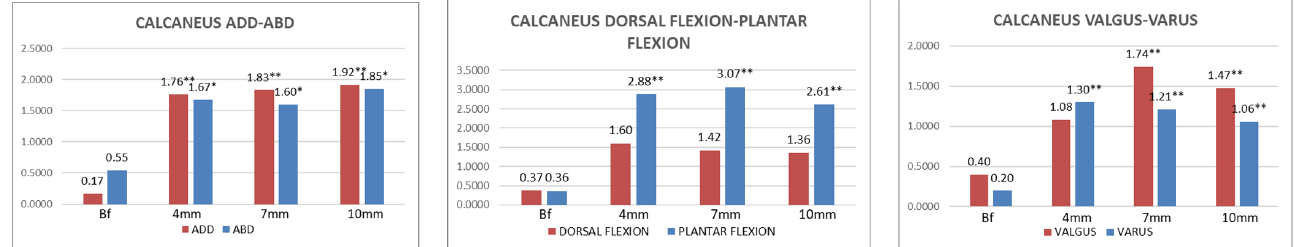
Figure 5. Graphical summary of the degrees of movement in adduction, abduction, dorsal flexion, plantar flexion, valgus, and varus for the calcaneus bone in four different conditions. Abbreviations: Bf = barefoot; 4 mm = lateral insoles, 4 mm; 7 mm = lateral insoles, 7 mm; 10 mm = lateral insoles, 10 mm. p -Value = level of significance; p < 0.05 * (with a 95% confidence interval) was considered statistically significant, and p < 0.001 ** (with a 95% confidence interval) was considered strongly statistically